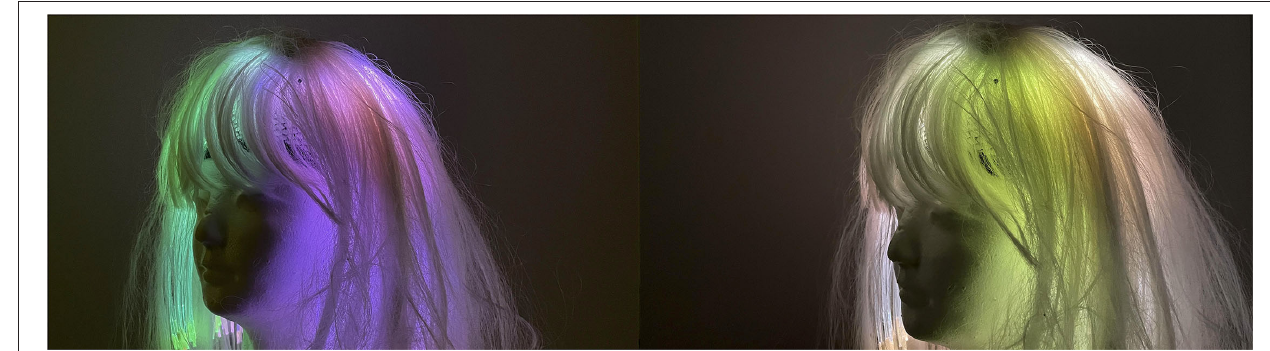
FIGURE 3 | The wig prototype for artificial hair displaying different colors.